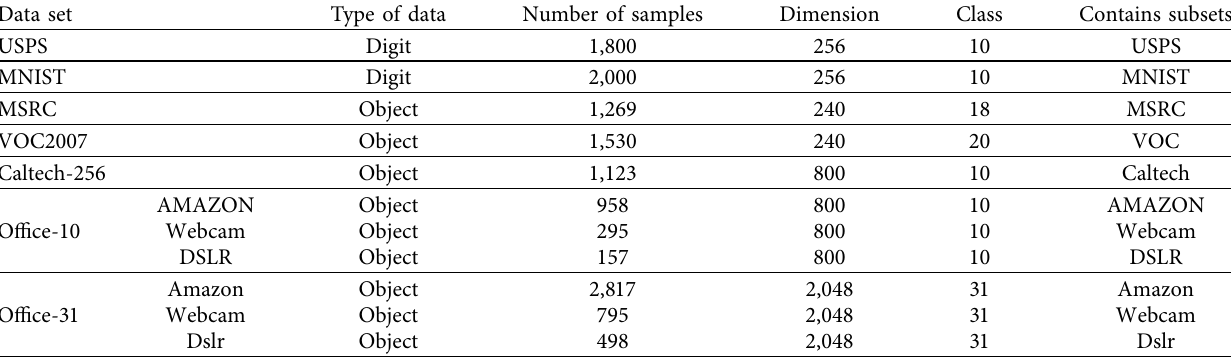
Table 1: Description of image data sets.